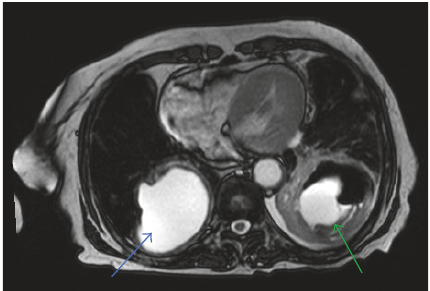
Figure 6: Axial T2 weighted image shows a large cyst in the right lower lobe representing parenchymal hydatid cyst (blue arrow); there is also a large cyst with air seen in the left lower lobe representing hydatid cyst in the left lung (green